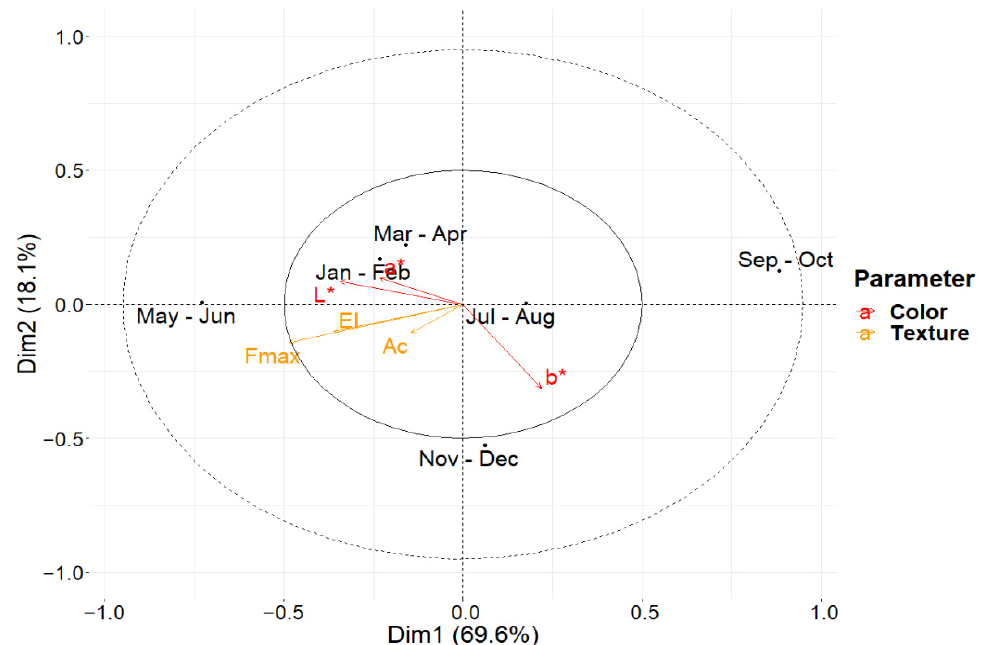
Figure 8. Biplot for ASCA showing the values for the first two principal components for the LMM- ASCA decomposition to the factor “Time”. Score values for each level are represented by black dots, labeled using the first three letters of the two months of each couple of months when the cheese wheels were sampled. Loading values are represented using arrows for each parameter acquired, and colored according to the type of the measurement: “El” stands for elastic modulus; “Ac” for area under the curve; “Fmax” for maximum force; “L*”, “a*”, and “b*” labels are referred to the coordinates of the lab color spaces.